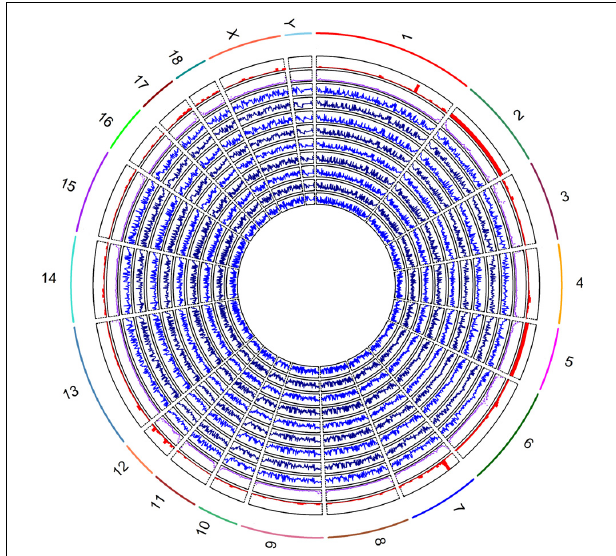
FIGURE 2 | Global methylation levels of nine samples was shown by lines of in blue (track 1, 2, 3, 4, 5, 6 7, 8, and 9) from inside to outside. The methylation levels and the densities of CpG islands by scatter plot in purple color (track 10), and genes by histograms in red color (track 11) were counted by 1 Mb windows. The labels of outside track represented the chromosomes of the porcine